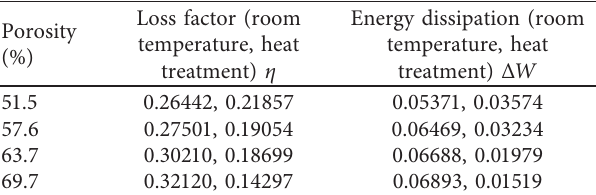
Figure 10: Comparison of normal temperature and heat treatment of test samples with different porosities. (a) Porosity � 51.5%. (b) Porosity � 57.6%. (c) Porosity � 63.7%. (d) Porosity � 69.7%. Table 2: Change of loss factor and energy dissipation with porosity after heat